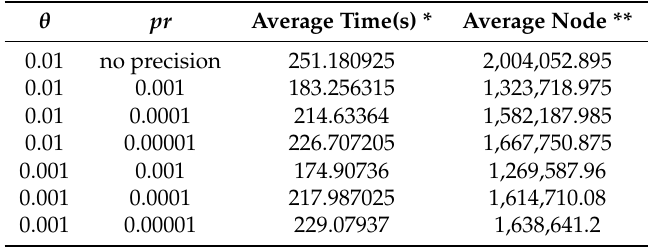
Figure 6. Number of positions solved, unsolved, and out of bounds by PPNS. ( a ) θ = 0.01, ( b ) θ = 0.001. The application of the pr parameter in PPNS increases the total positions that are concluded (solved or unsolved). The optimal configuration is θ = 0.001 and pr = 0.001 with a total of 135 positions. This configuration is higher than that of PNS (122 positions) and MCPNS (82 positions) from the previous experiment. Elapsed time and nodes explored are also affected by the application of the pr value. The average elapsed time and nodes explored are given in Table 1. The change of θ value does not significantly affect the average time and node, but an increase in the pr value yields a longer elapsed time, and a higher number of nodes visited. A small number of pr value leads to an increase in the total number of positions. However, lowering the pr value to a rate where it is less precise than that of θ would lead to false conclusions. In this case, the best pr value would be of the same with θ , or one rate above it (smaller pr ). Table 1. Average time and node for each PPNS